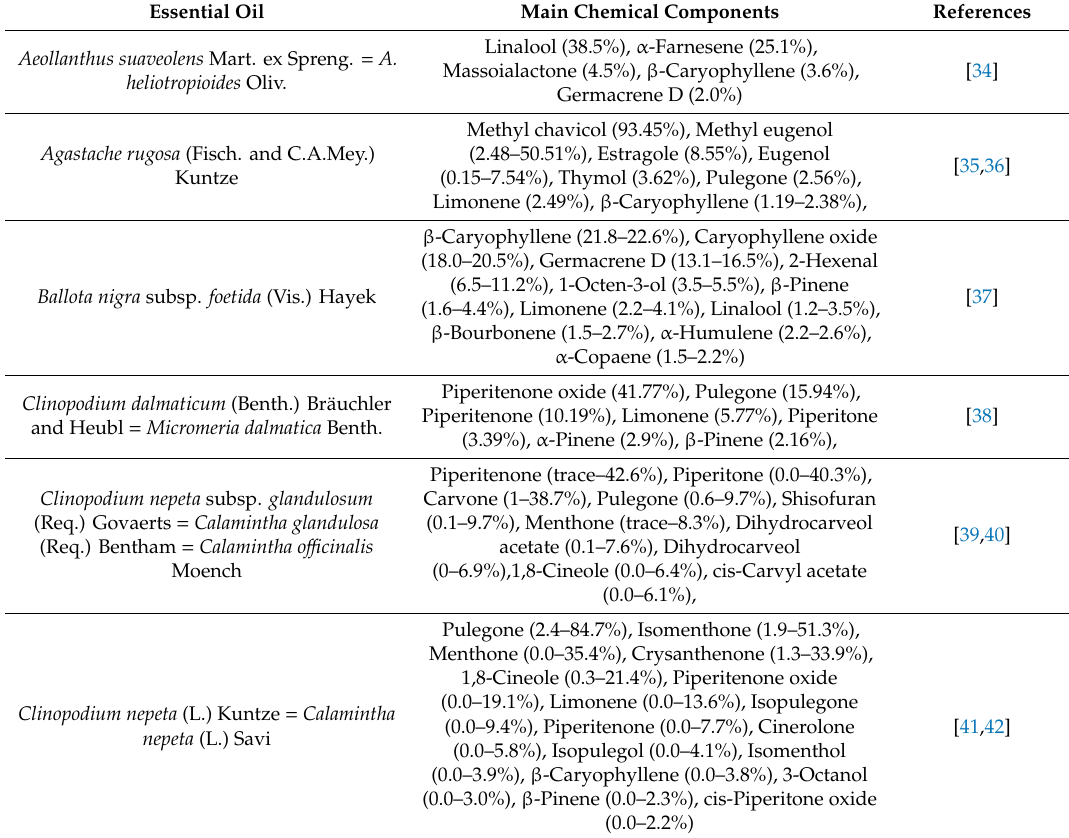
Table 2. The main chemical components of the essential oils of selected Lamiaceae family plants. Essential